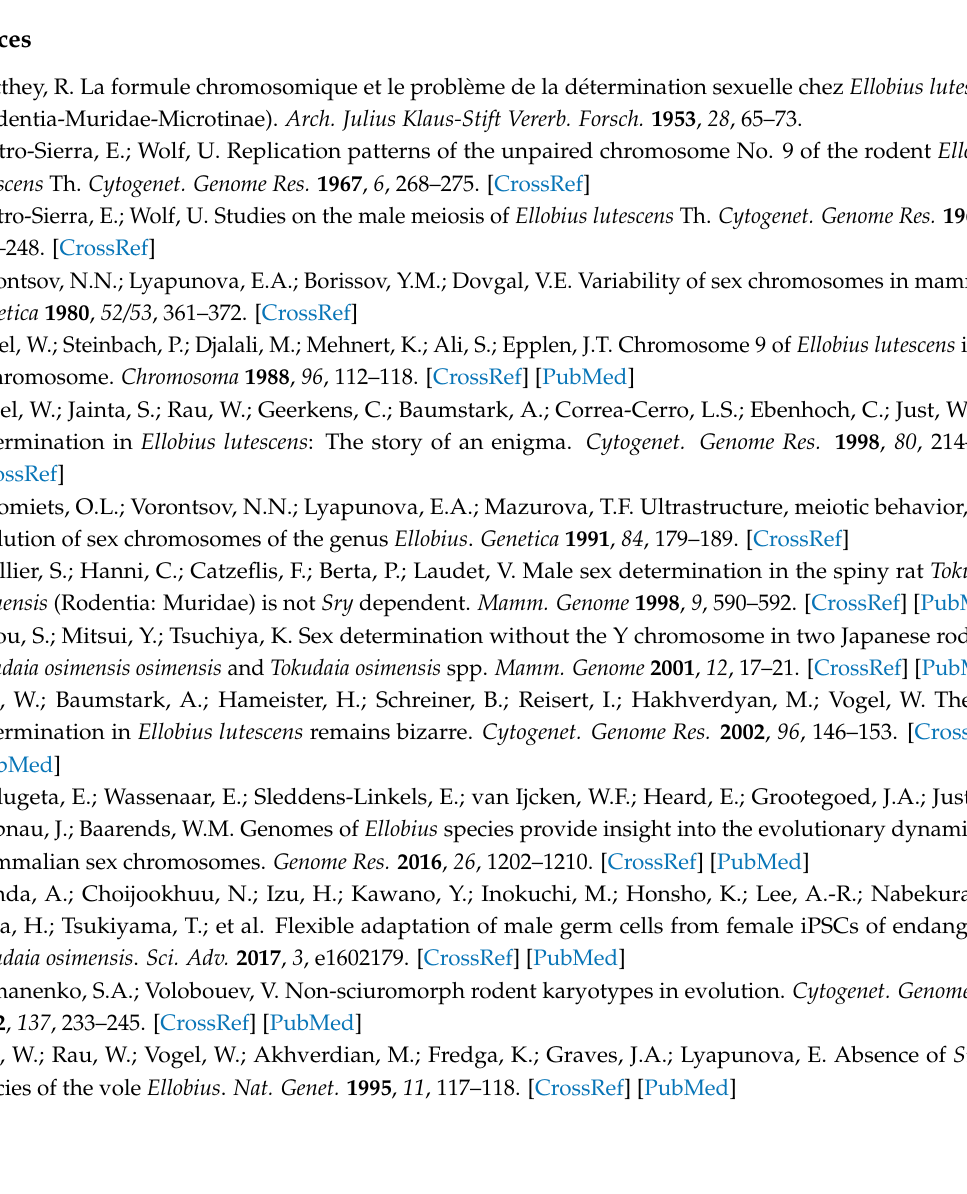
Figure S1: Bayesian inference for the data of the Eif2s3y sequences of five Ellobius species was evaluated in MrBayes ver. 3.2.; Table S1: Specificity of the Sry , Eif2s3x and Eif2s3y genes in 5 species of Ellobius and GenBank accession numbers; Table S2: Fragments of sequences of Sry gene for sex-determining region Y protein and Eif2s3x, gene for eukaryotic translation initiation factor 2 subunit